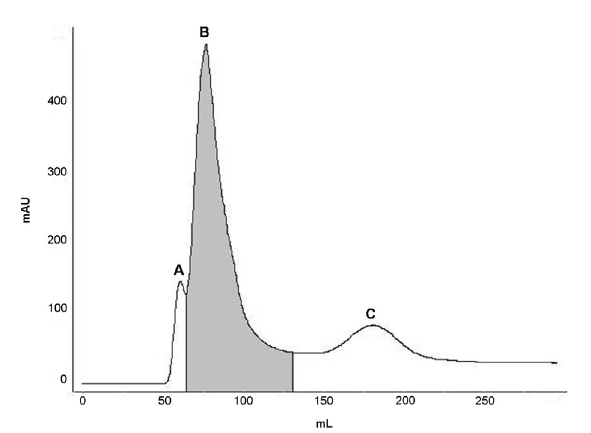
Figure 3. The fractions under peak B in the